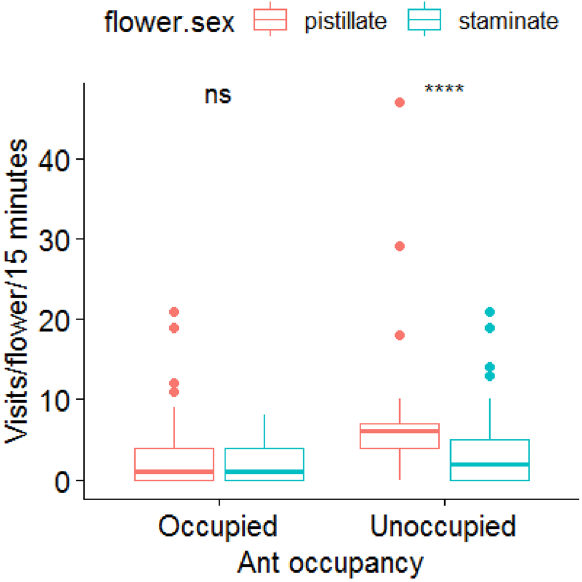
Figure 2. Visitation rate of pollinators to ant-occupied and ant-unoccupied staminate and pistillate flowers of Cucurbita maxima . **** p = 0.009.